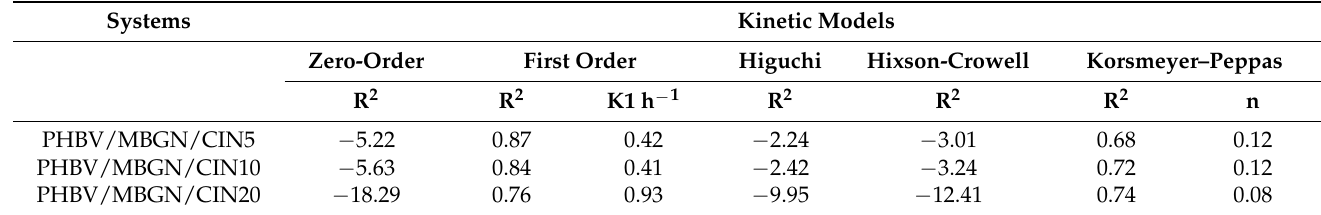
Table 2. Mathematical kinetic models applied to in vitro CIN cumulative release (%) of